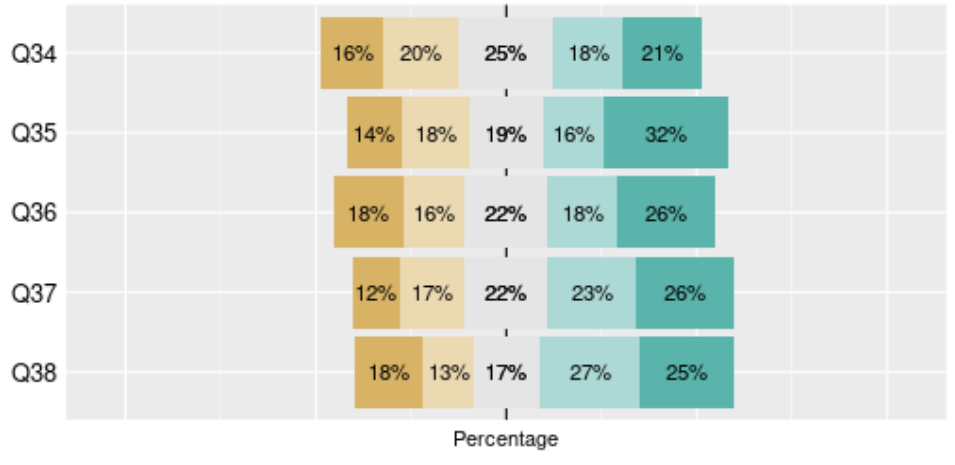
Figure 8. Results related to the Information Security